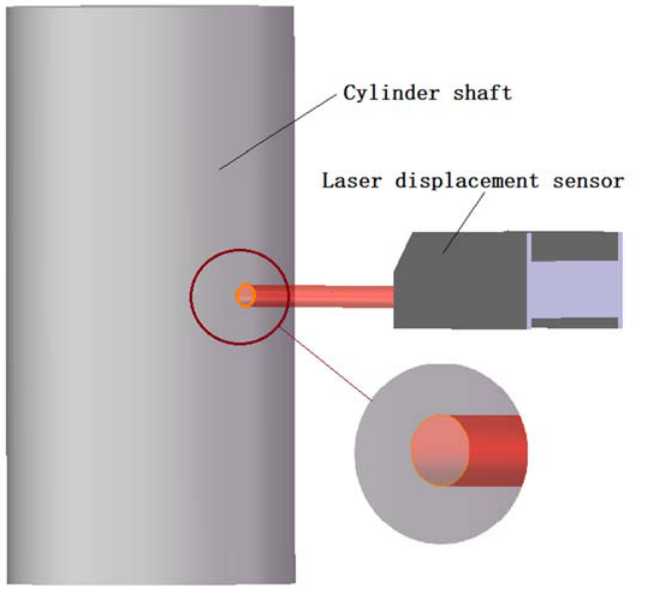
Figure 2. The spot shape when the laser beam is facing the center of the shaft.